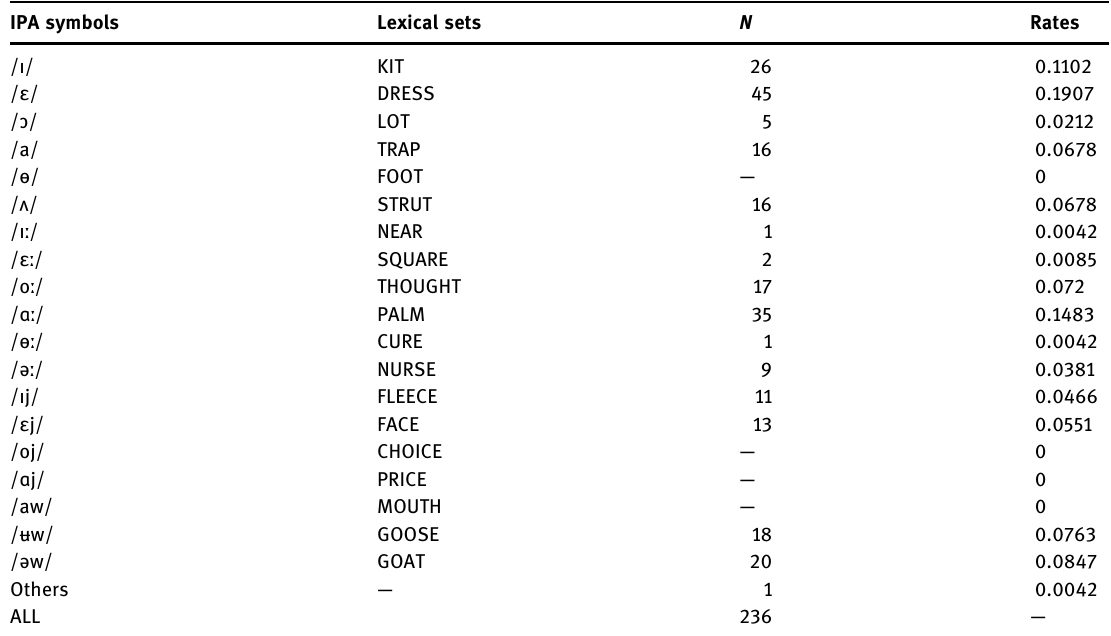
Table 4: Frequency of vowels IPA symbols Lexical